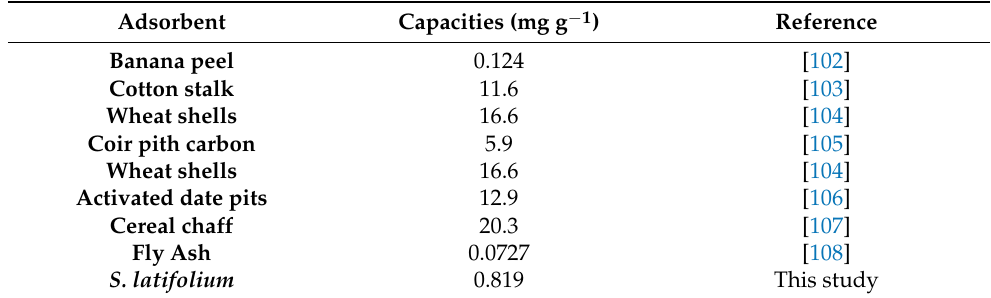
Figure 11. Linear Langmuir isotherm for MBD sorption. Table 3. Comparison of higher monolayer sorption of MBD onto different adsorbents materials.